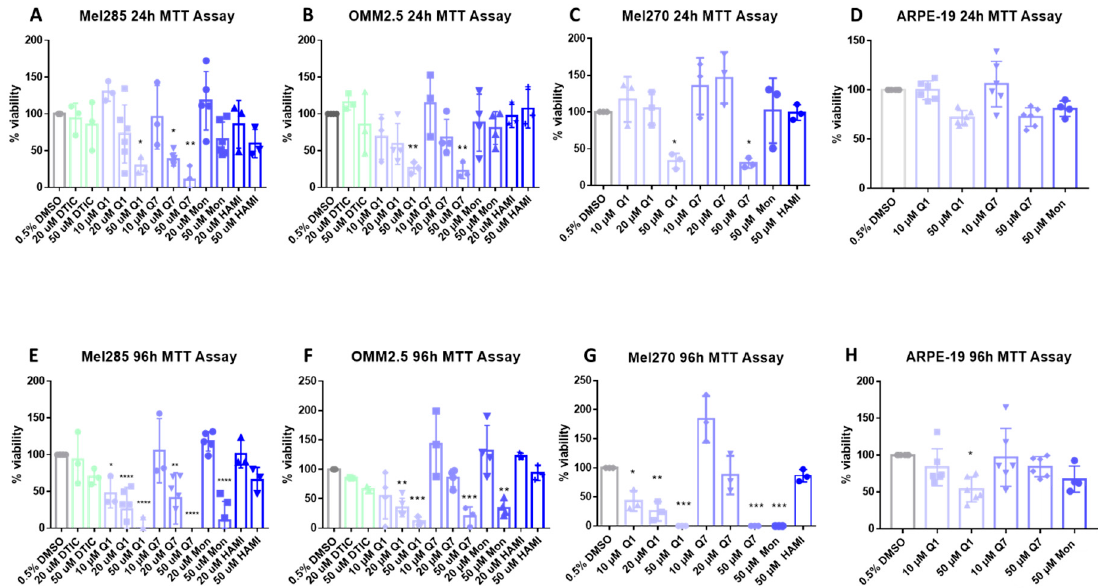
Figure 5. CysLT 1 antagonists reduce cell viability in uveal melanoma cell lines. Graphs represent the e ff ects of treatment with varying concentrations of dacarbazine (DTIC), quininib (Q1), 1,4-dihydroxy quininib (Q7), montelukast (Mon), and HAMI 3379 (HAMI) for 24 and 96 h in Mel285 ( A , E ) ( n = 3 / n = 6), OMM2.5 ( B , F ), ( n = 3 / n = 4), Mel270 ( C , G ) ( n = 3) and ARPE-19 ( D , H ) ( n = 4 / n = 6) cell lines. Treatment with 50 µ M of quininib, 1,4-dihydroxy quininib, and montelukast for 96 h significantly reduced cell viability in Mel285 ( E ), OMM2.5 ( F ), and Mel270 ( G ) cells. ( D ) Quininib analogues had no e ff ect on ARPE-19 cells at 10 or 50 µ M following 24 treatment. ( H ) 50 µ M of quininib reduced ARPE-19 viability at 96 h. Viability of cells was determined using MTT (3-(4,5-dimethylthiazol-2-yl)-2,5-diphenyltetrazolium bromide) assay. 5000 cells were seeded and treated in triplicate for each individual experiment. Statistical analysis was performed by ANOVA with Dunnett’s post hoc multiple comparison test. Error bars are mean + S.E. * p < 0.05; ** p < 0.01; *** p < 0.001; **** p < 0.0001.